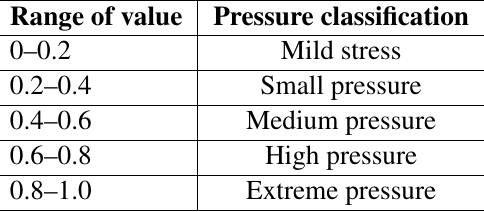
Table 7 Classification of pressure